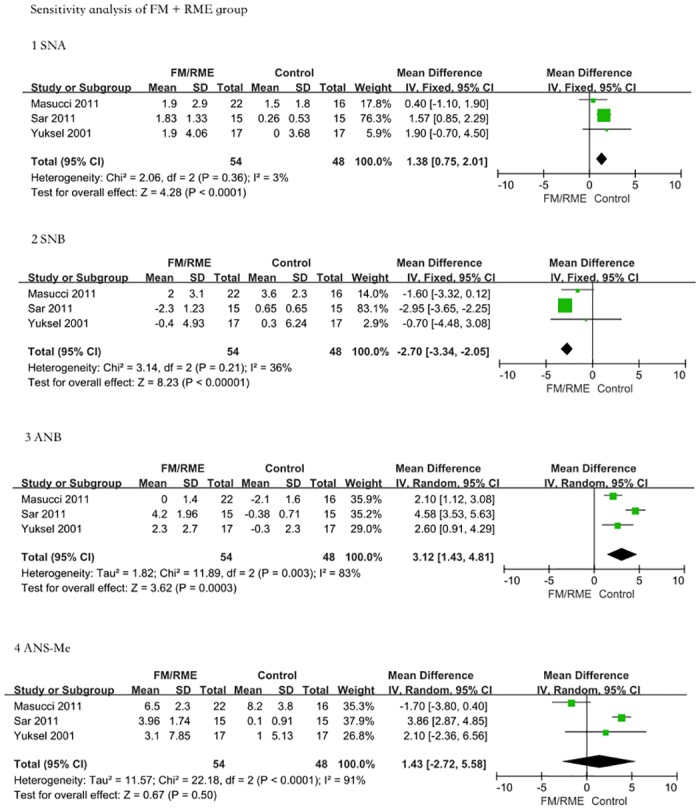
Sensitivity analysis.The same method was used in the FM/RME group; we also chose 3 relatively high-quality studies (score ≥ 4) to carry out the sensitivity analysis. The comparison was performed using five indices. 1: Angle SNA: The FM/RME treatment group presented a greater increase in SNA than the controls (MD = 1.38, 95% CI = 0.75–2.01, P < 0.0001). 2: Angle SNB. The FM/RME treatment group presented a greater decrease in SNB than the untreated controls (MD = -2.70, 95% CI = -3.34–-2.05, P < 0.00001). 3: Angle ANB. The FM/RME treatment group presented a greater increase in ANB than the controls (MD = 3.12, 95% CI = 1.43–4.81, P = 0.0003). 4: ANS-Me length. There were no significant differences in ANS-Me length between the FM/RME treatment group and untreated controls (MD = 1.43, 95% CI = -2.72–5.58, P = 0.50). The sensitivity analysis result was consistent with previous results.